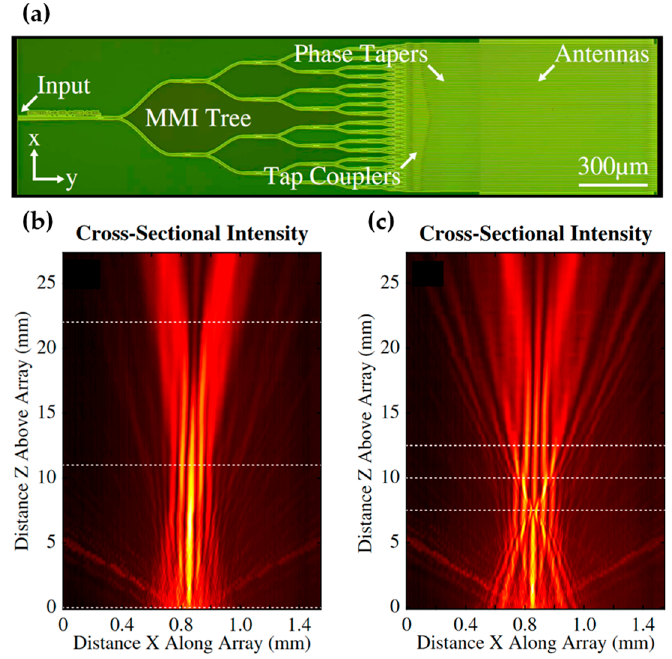
Figure 11. ( a ) Optical image of an OPA for quasi-Bessel beam generation [82]. ( b ) The measured quasi-Bessel beam from the OPA in ( a ). ( c ) The measured intensity distribution of a quasi-Bessel beam blocked by a gold wire. Reprinted with permission from [82] © The Optical Society.